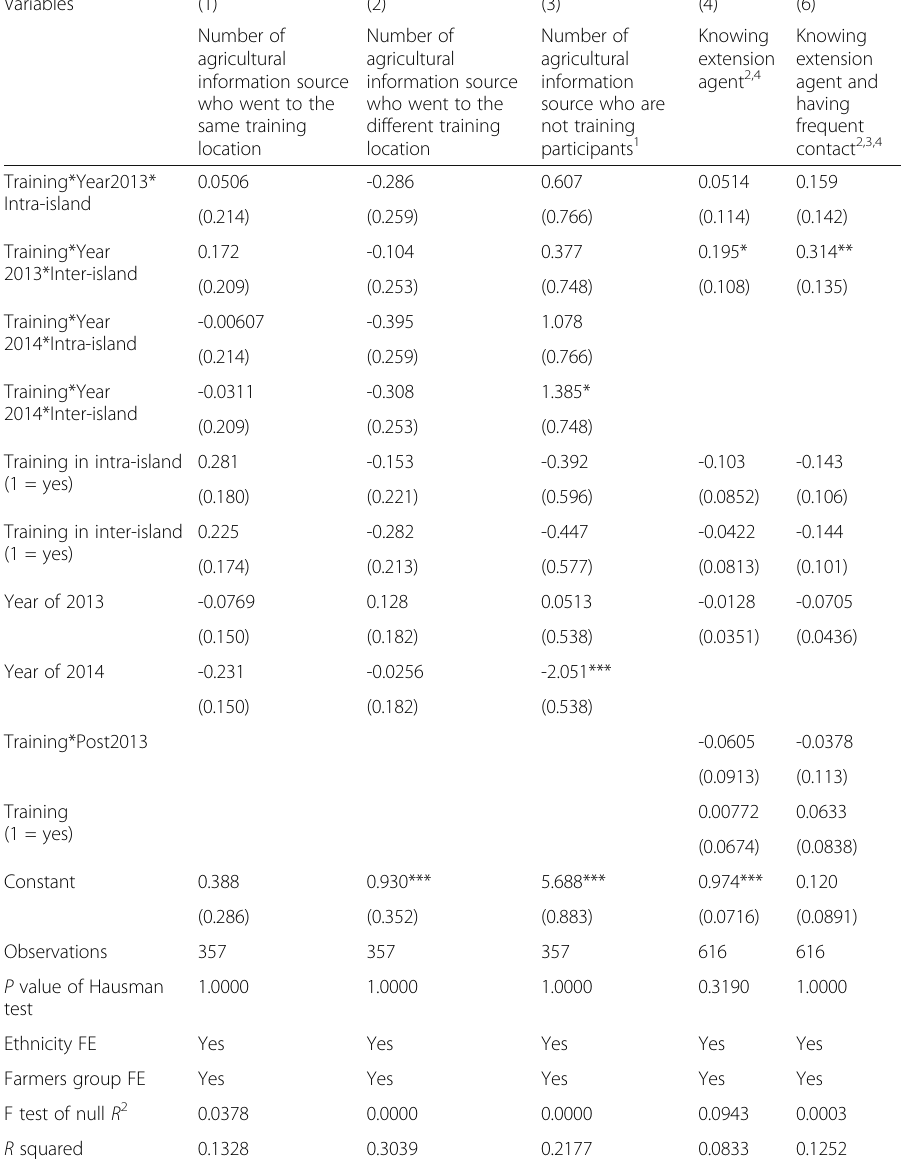
Table 6 Effects of training on the size and depth of social networks